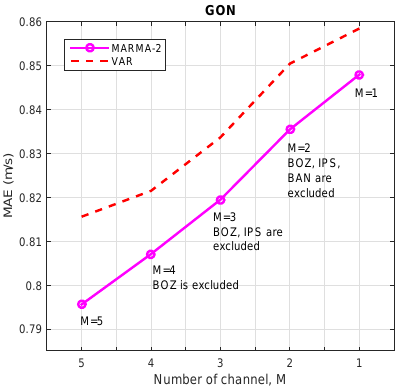
Figure 11. MAE performances of the VAR and MARMA-2 models with respect to number of channel M when m = 3 (GONEN) and ∆ = 2 h.